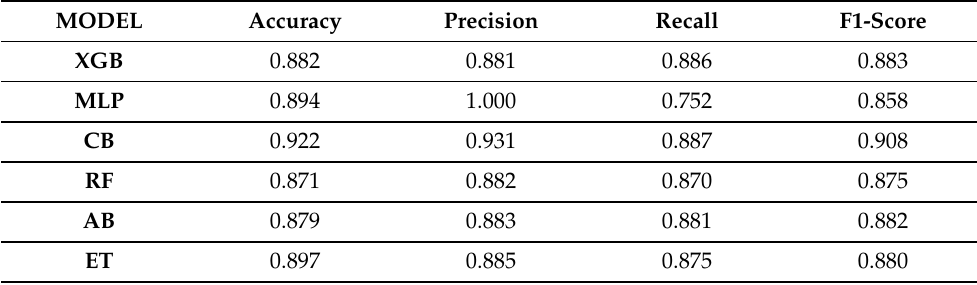
Table 1. The comparative performance of the classifiers used for the classification of IDC(+) and IDC(-) images after